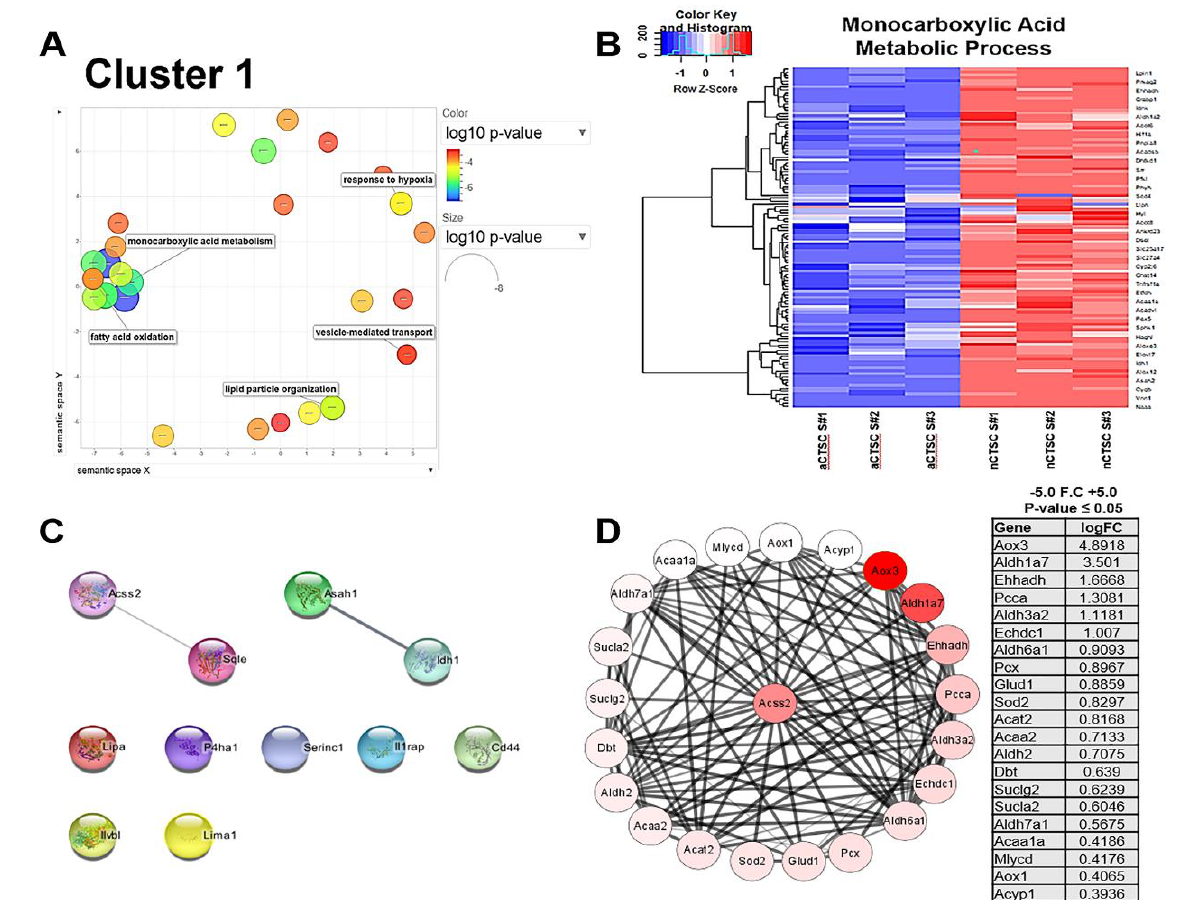
Figure 4. Metabolic processes in cluster 1 related to ACSS2. ( A ) REVIGO analysis of cluster 1 visualizing similar GO terms grouped together in semantic space. ( B ) Heatmap of GO terms: monocarboxylic acid metabolic process. ( C ) Top 10 genes present in cluster 1 identified by STRING database and visualized through Cytoscape to show potential interaction with ACSS2. ( D ) Protein – protein interaction network of genes from cluster 1 that directly interact with Acyl-CoA synthetase short-chain family member 2 protein (ACSS2). Color of each protein ranges from white to red and corresponds to each gene logFC.